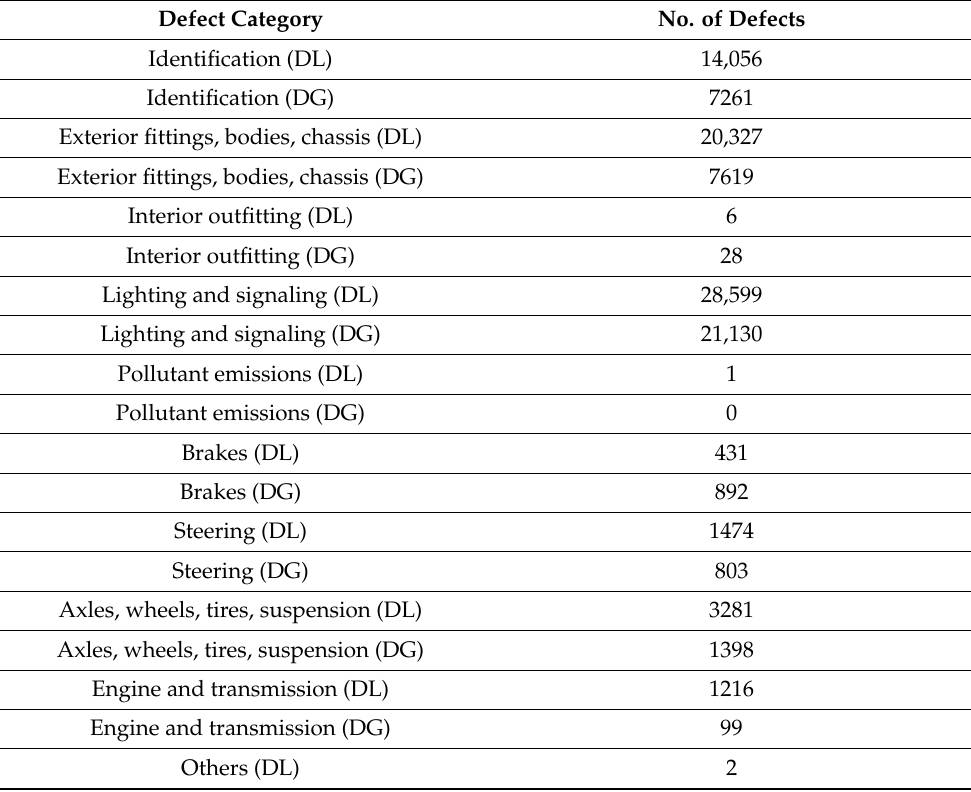
Table 3. Number of defects classified by category in the period